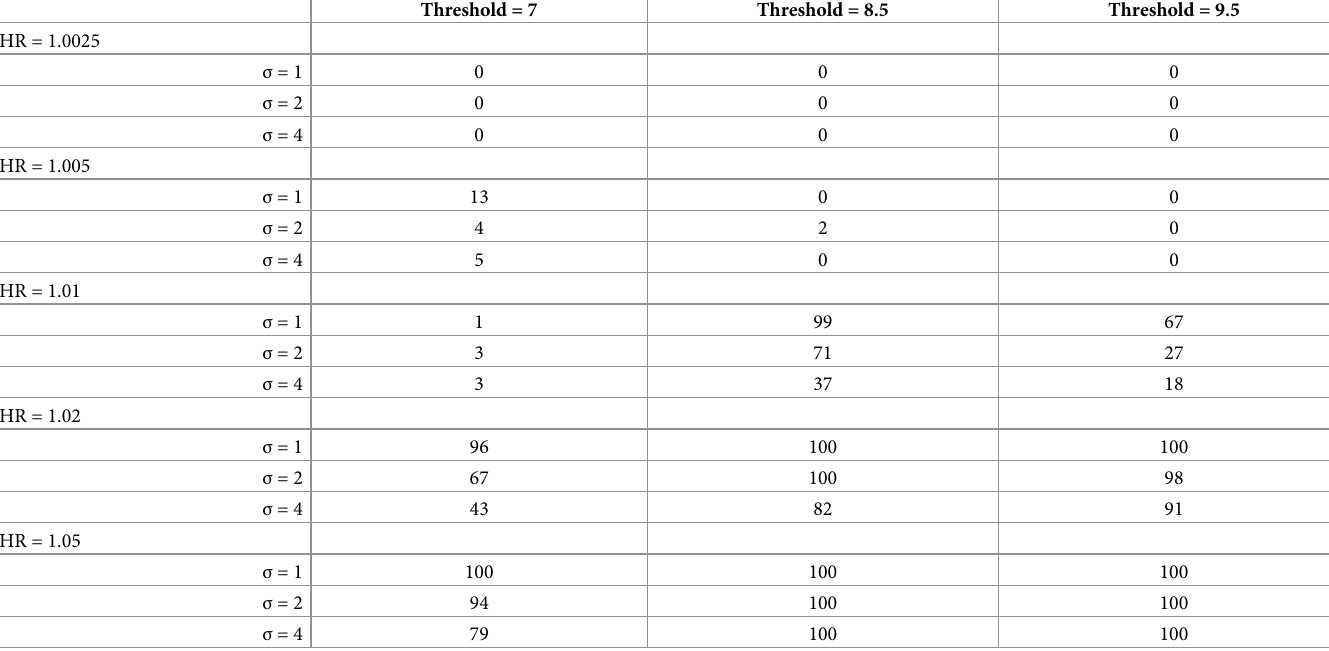
Table 1. Rejection of the no C-R threshold model under varying amounts of measurement error. Threshold = 7 Threshold = 8.5 Threshold =